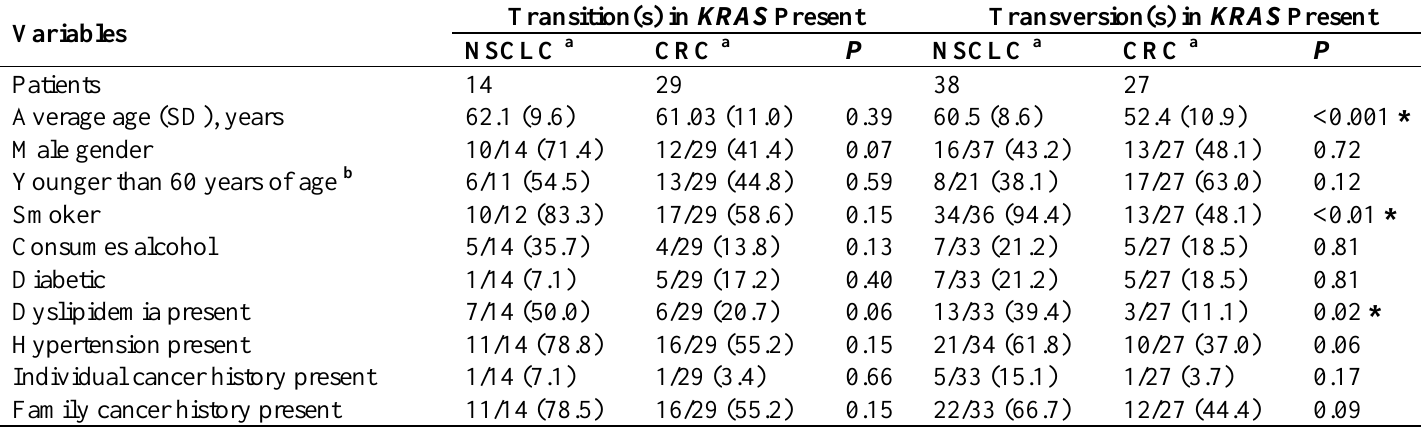
Table 4. Clinical and metabolic parameters in non-small cell lung carcinoma (NSCLC) and colorectal cancer (CRC) patients with transition or transversion mutations in KRAS .